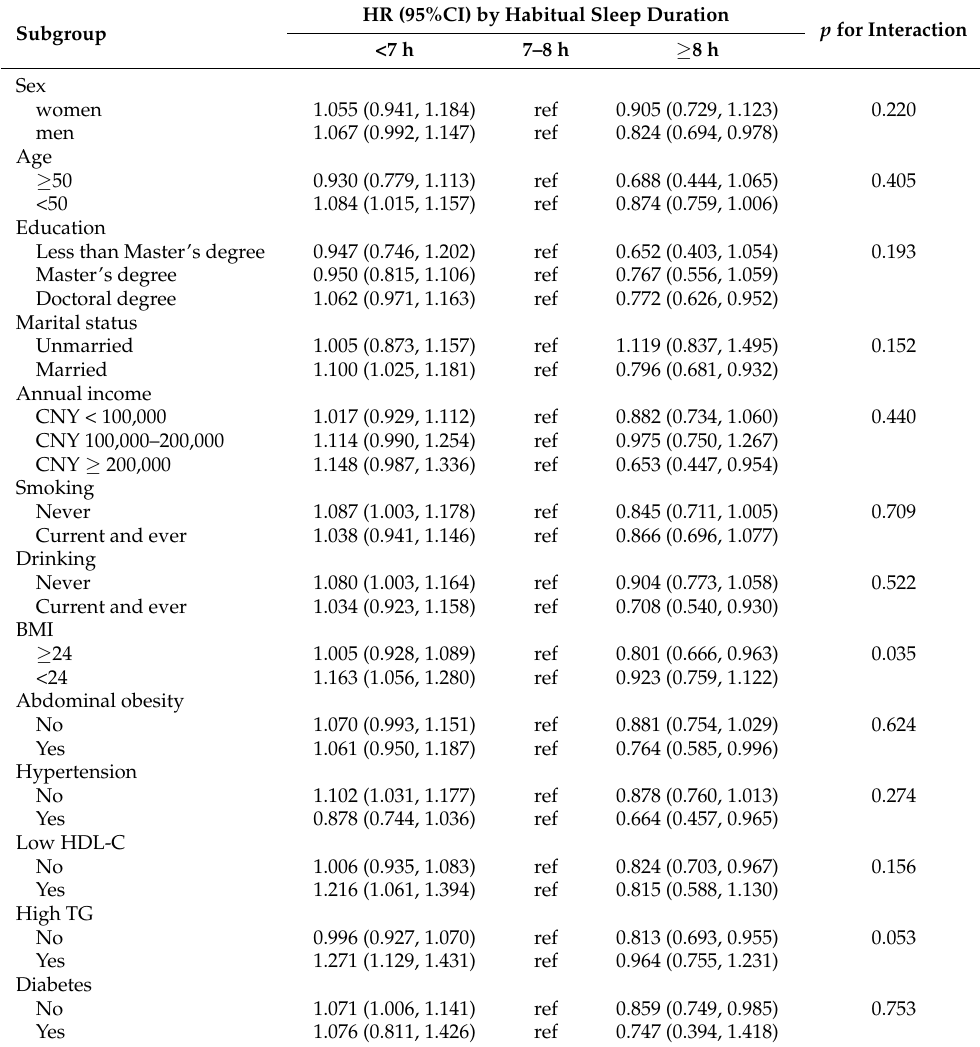
Table 3. Association of sleep duration with risk of hyperuricemia in different subgroups and interactions.